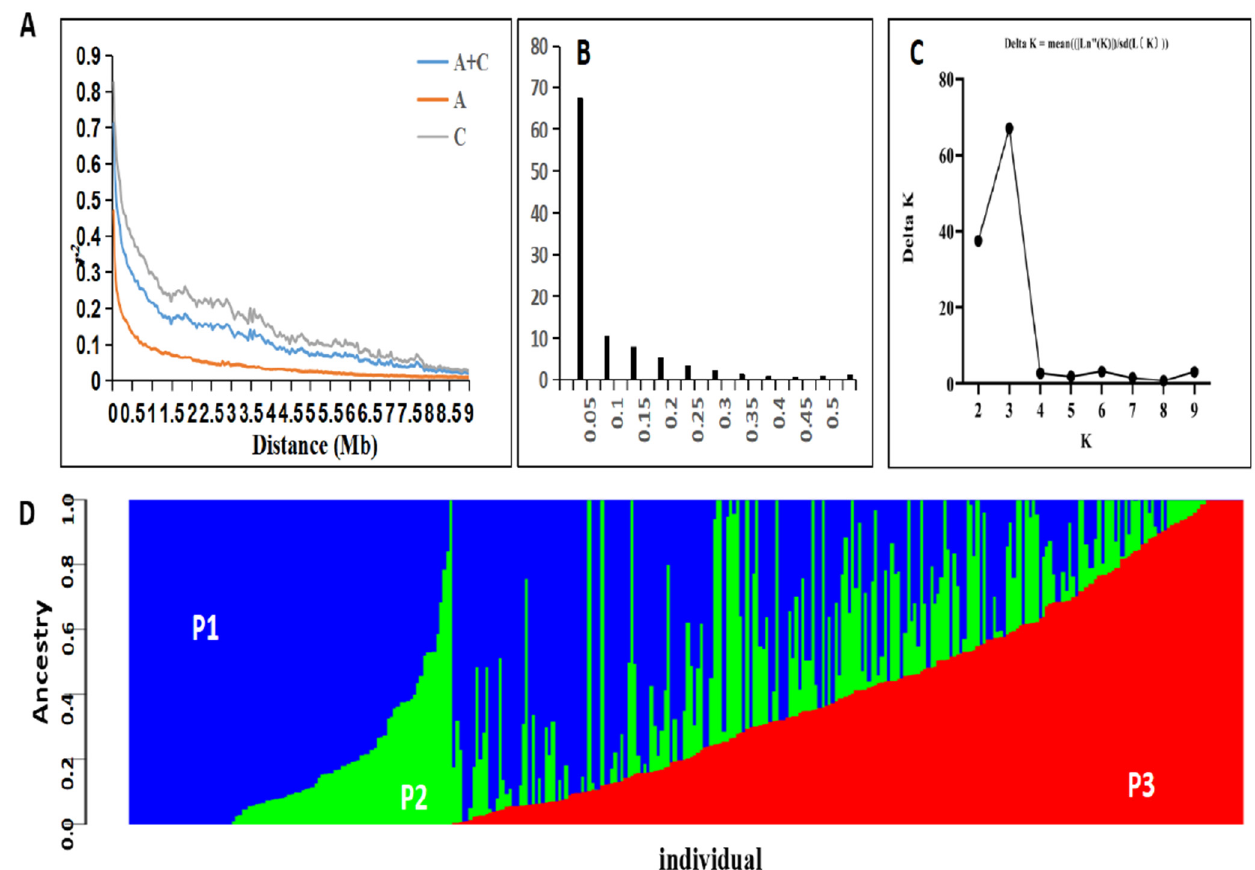
Figure 2. Linkage disequilibrium (LD) analysis and population structure and relative kinships of the 338 B. napus accession populations. ( A ) Linkage disequilibrium decay calculated by squared correlations of allele frequencies (r 2 ) against the distance between polymorphic sites in the A subgenome (red), C subgenome (grey), and A + C subgenome (blue). ( B ) Distribution of pairwise relative kinship estimates in the entire population. ( C ) The log-likelihood of the data (LnP[D]) of possible clusters (K) from one to 10. ( D ) Structure of the population based on K = 3. Subpopulations 1, 2, and 3 are represented by P1, P2, and P3, respectively.